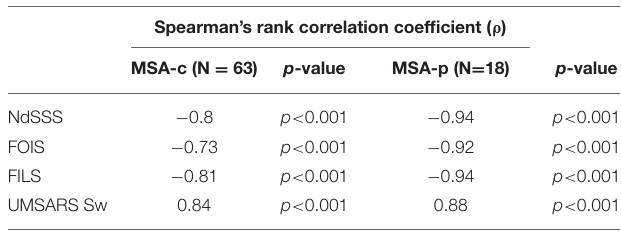
TABLE 3 | Spearman’s rank correlation coefficients between the Global Disability Scale and swallowing function clinical scales according to disease subtype. Spearman’s rank correlation coefficient ( ρ )